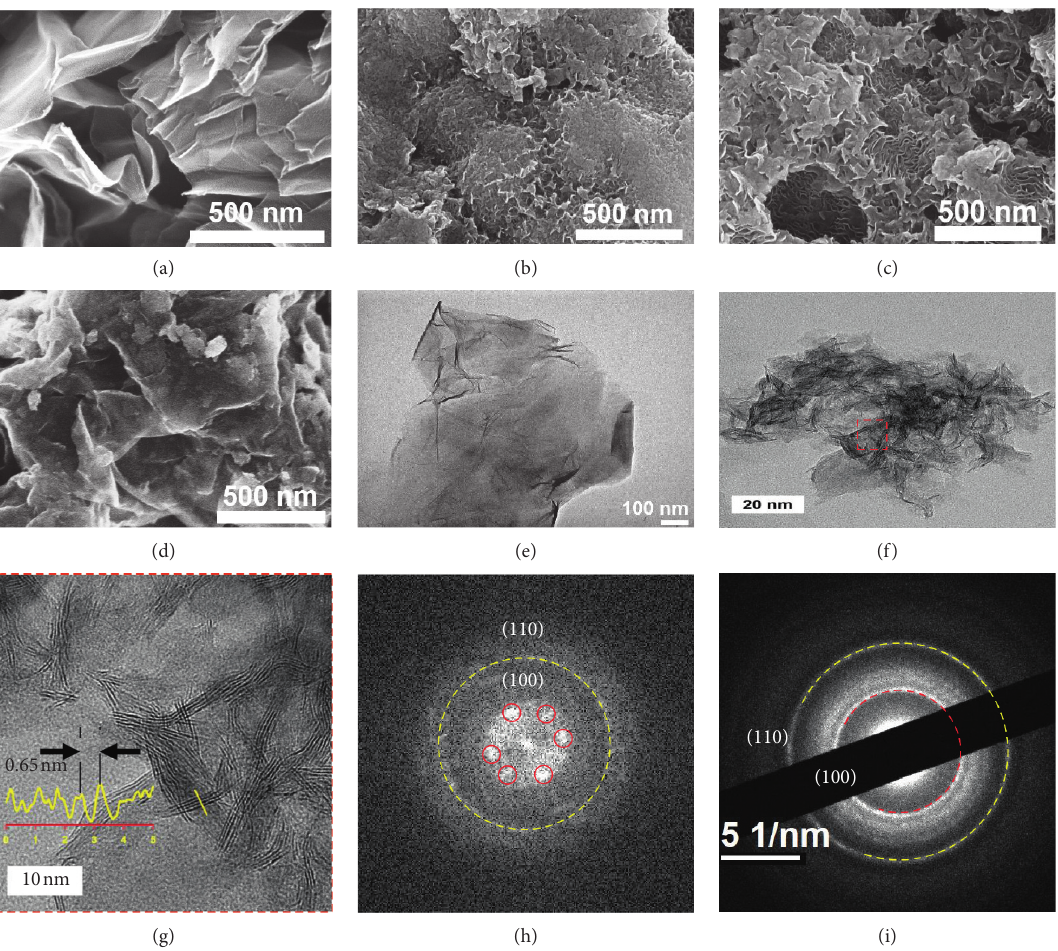
Figure 2: SEM images of rGO (a), MS (b), MMS (c), and 3%MMS/rGO (d). TEM images of rGO (e), 3%MMS/rGO (f, g), FFT (h), and SAED (i) of 3%MMS/rGO.